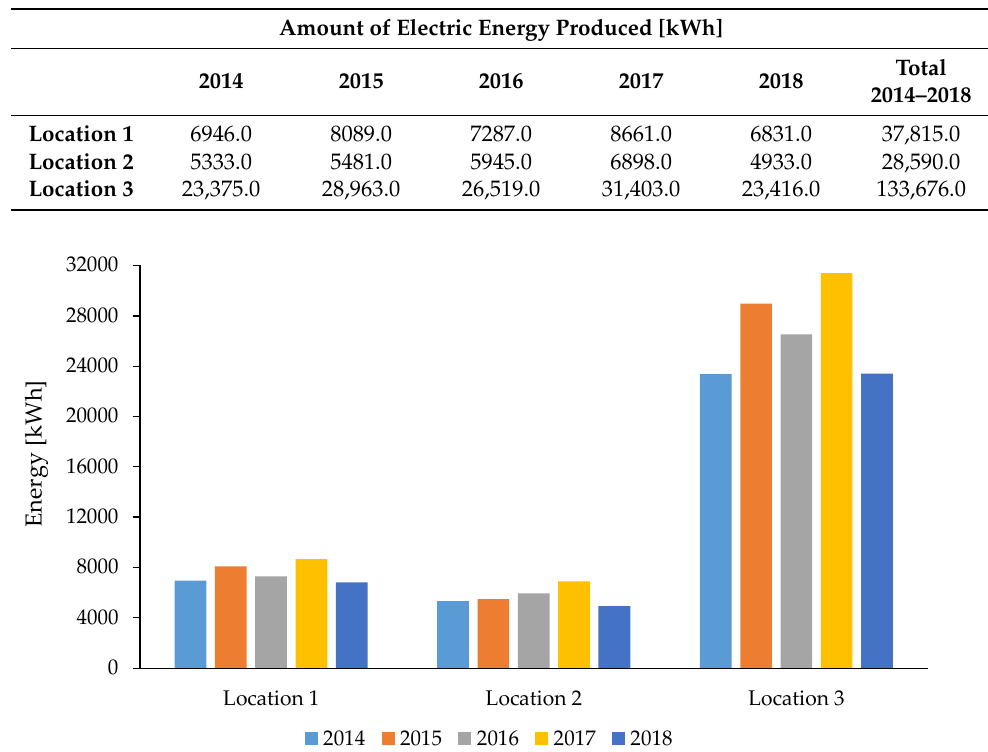
Table 4. Simulation results for energy production at the tested locations between 2014 and 2018.